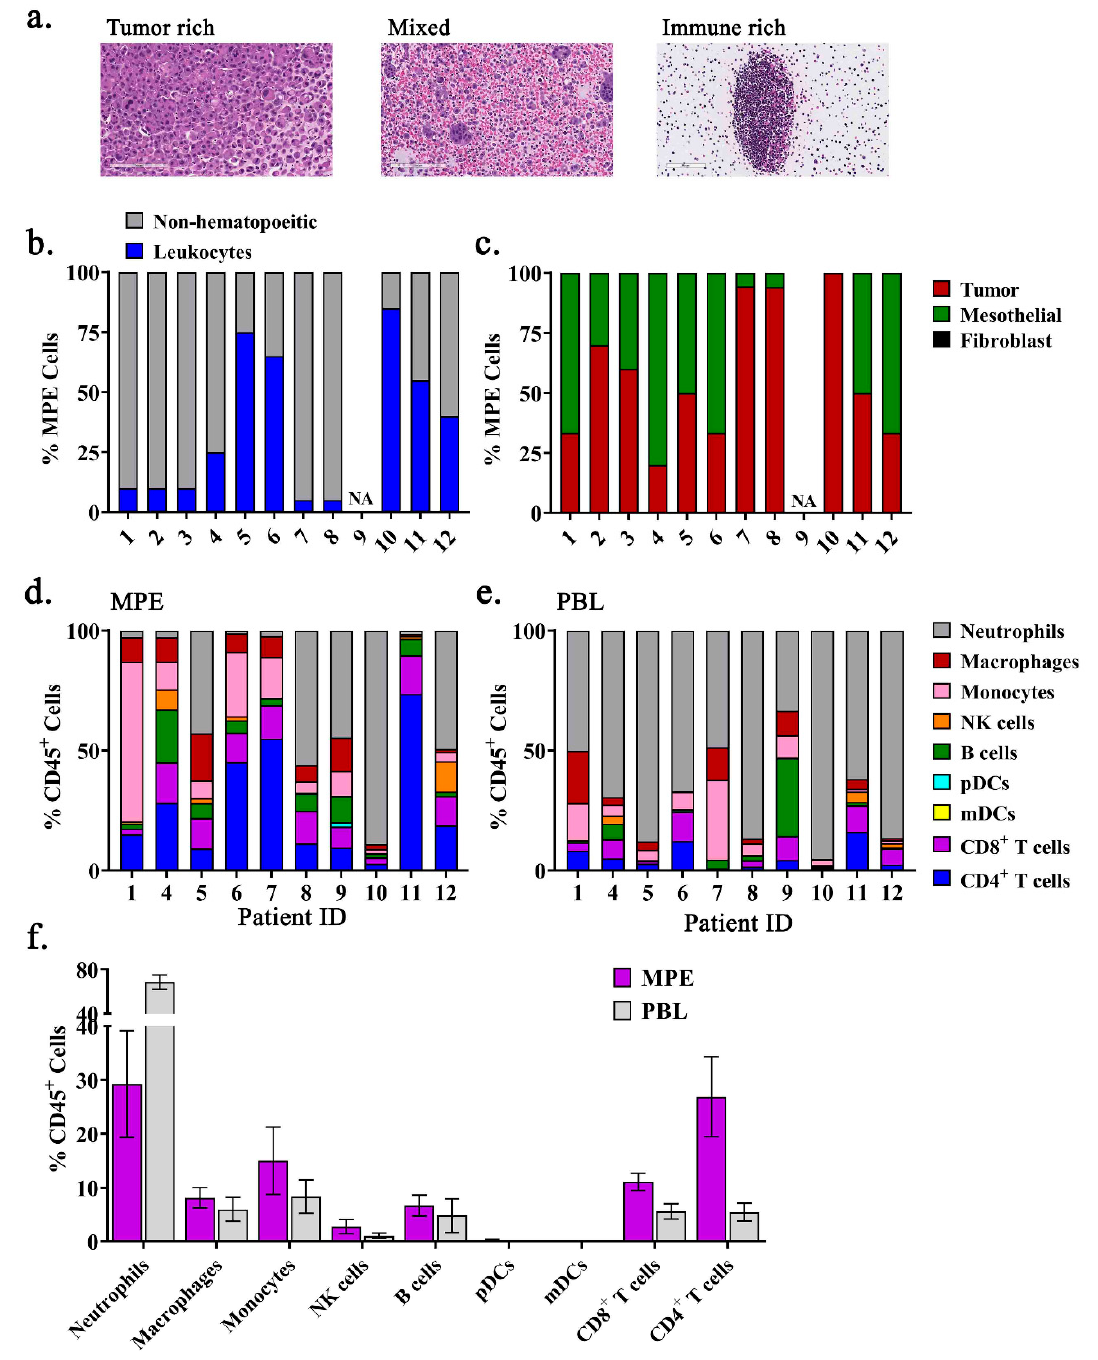
Figure 1. Immunophenotyping reveals heterogeneous composition of MPEs. ( a ) Representative images depicting MPEs rich in tumor cells, immune cells, or a mix of both within cytopathologic specimens. ( b ) Proportions of non-hematopoietic cells and leukocytes in MPEs, and ( c ) representation of tumor cells, mesothelial cells, and fibroblasts (absent) in the non-hematopoietic cell fraction of MPEs. Proportions of neutrophils (grey), macrophages (red), monocytes (pink), NK cells (orange), B cells (green), pDCs (light blue), mDCs (yellow), CD8 + T cells (purple), and CD4 + T cells (dark blue) from live, single, CD45 + leukocytes from ( d ) MPEs or ( e ) peripheral blood leukocytes (PBL) per patient were determined by multiparametric flow cytometry. ( f ) Population means ± SEM of immune cell subsets within MPEs and PBL.